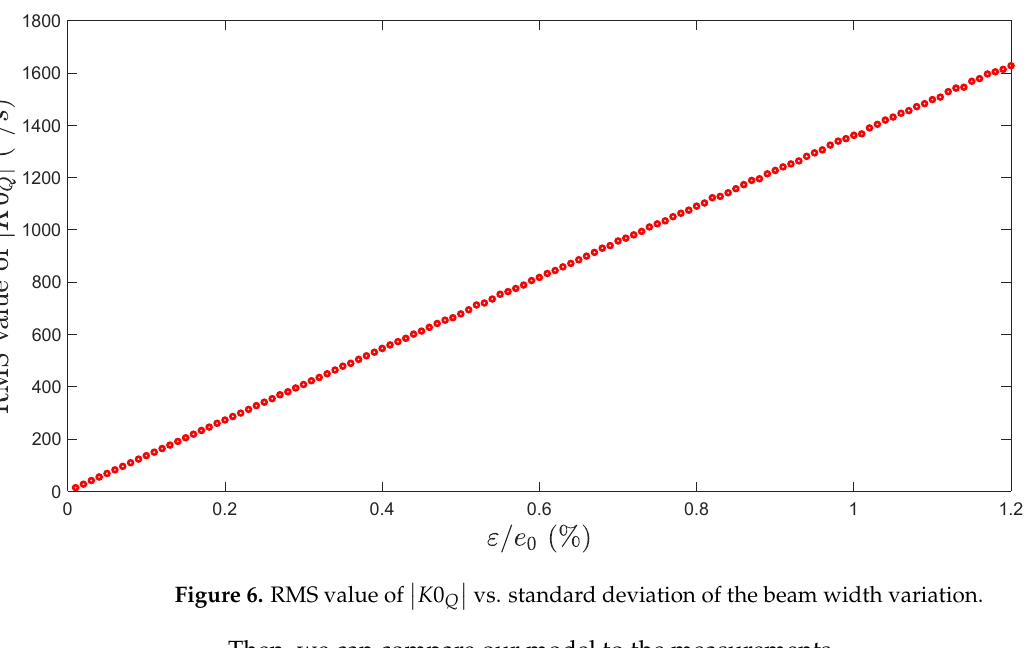
Figure 6. RMS value of (cid:3627)𝐾0 (cid:3018) (cid:3627) vs. standard deviation of the beam width variation.